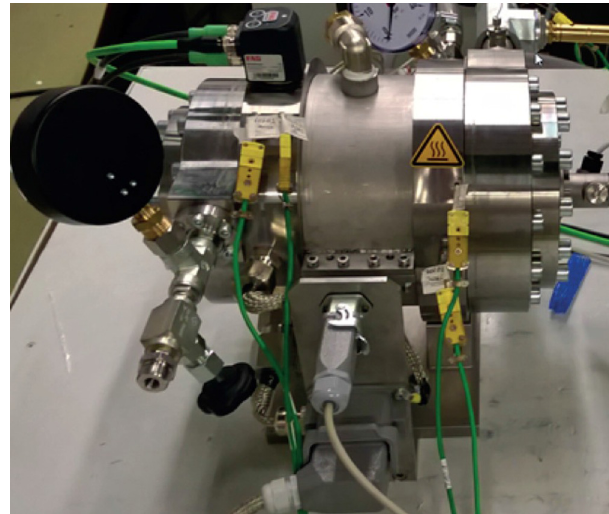
Fig. 7. sCO 2 -HeRo turbine alternator compressor.